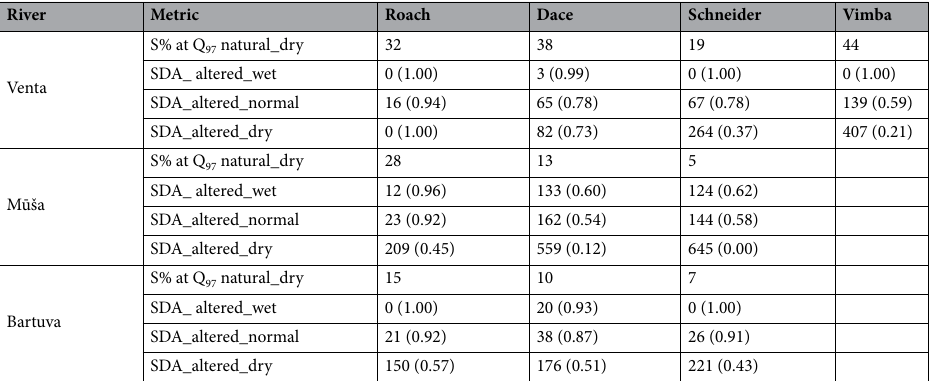
Table 5. The relative habitat area (% of river channel) of the modelled fish species at a discharge of Q 97 in a dry year at natural conditions (S% at Q 97 _reference_dry) and relative increase (in %) in the cumulative duration of stress days (stress days alteration; SDA) when the area of habitat falls below this threshold when HPPs function in a wet (SDA_altered_wet), normal (SDA_altered_normal) and dry (SDA_altered_dry) year. The value of the index of temporal habitat availability (ITH) is given in